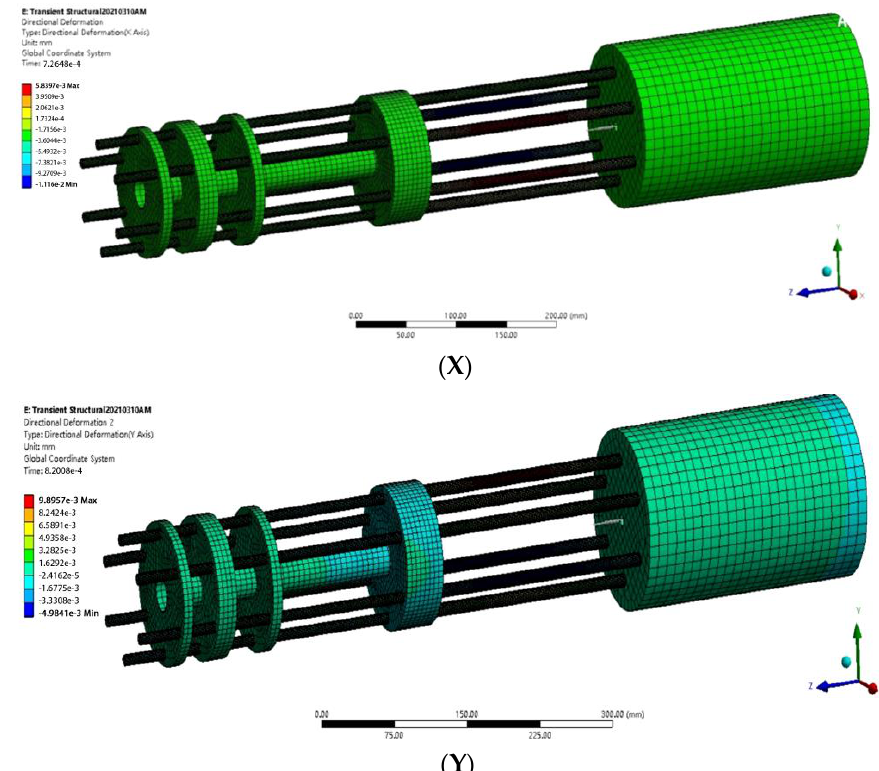
11 of 19 Figure 15. Bullet x (transverse) displacement. Figure 16. Bullet’ s force F1 and F2. 6. Optimization of the Cantilever Rotor System